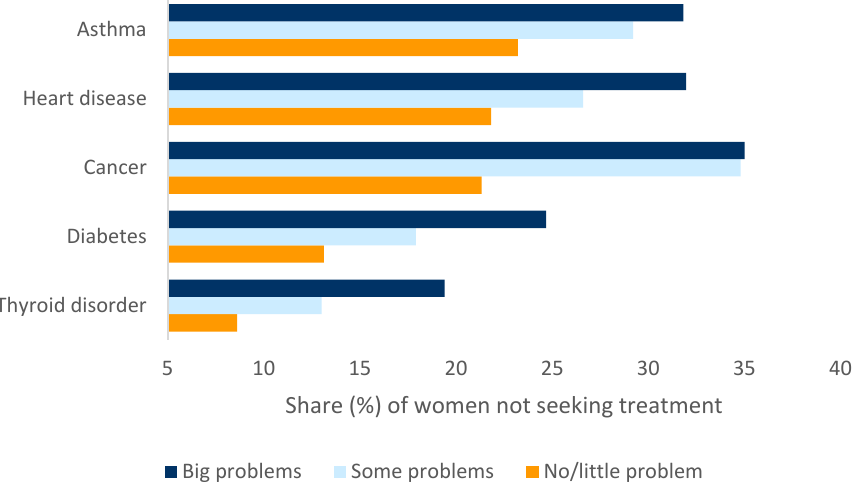
Figure 4. Validity check for the distribution of healthcare access problem severity (based on composite score). Sample for validity check contained women who reported certain disease conditions. Among them, the share of women who were (at the time of the survey) not seeking treatment for a problem is plotted on the horizontal axis against the respective disease condition and the severity of the healthcare access problems faced.